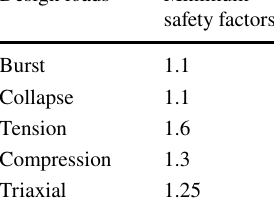
Table 3 Minimum design